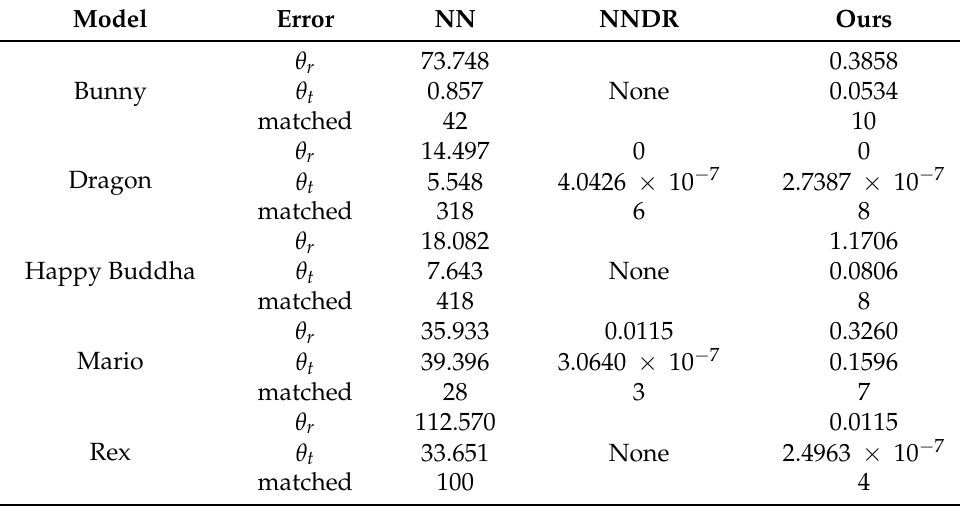
Table 2. Errors of three key point matching algorithms on models and scenes.